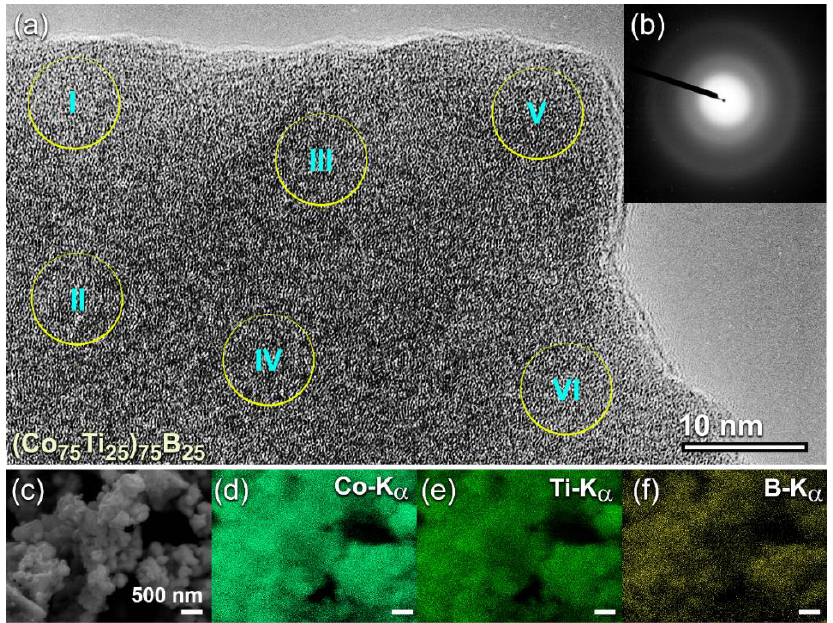
Figure 5. ( a ) FE-HRTEM, and ( b ) NBDP of (Co 75 Ti 25 ) 90 B 10 powders obtained after 50 h of MA time (end-product). The FE-HRTEM and corresponding NBDP for the end-product of (Co 75 Ti 25 ) 85 B 15 are displayed together in ( c ) and ( d ), respectively.